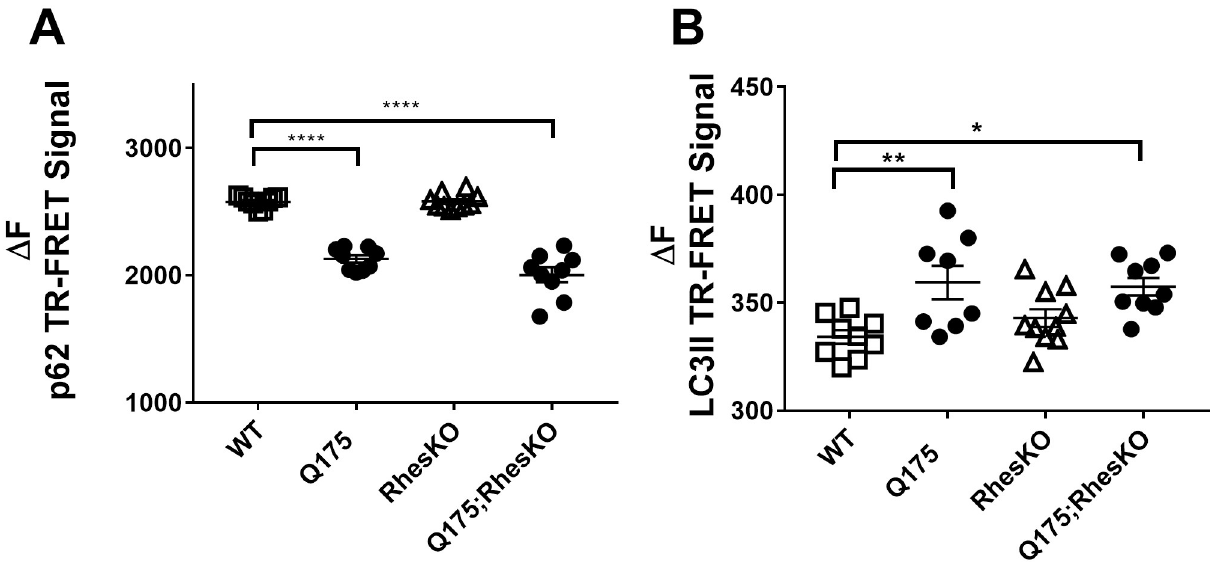
Fig 7. RhesKO did not modulate autophagy in female Q175 mice. TR-FRET for p62 (A) and lipidated LC3II (B) was performed on 12 month female mouse striatum. Data are expressed as mean ± SEM (WT n = 9; RhesKO n = 11; Q175 n = 9); Q175;RhesKO n = 9; One-way ANOVA statistical analysis: � p < 0.05, �� p < 0.01, ���� p < 0.0001).